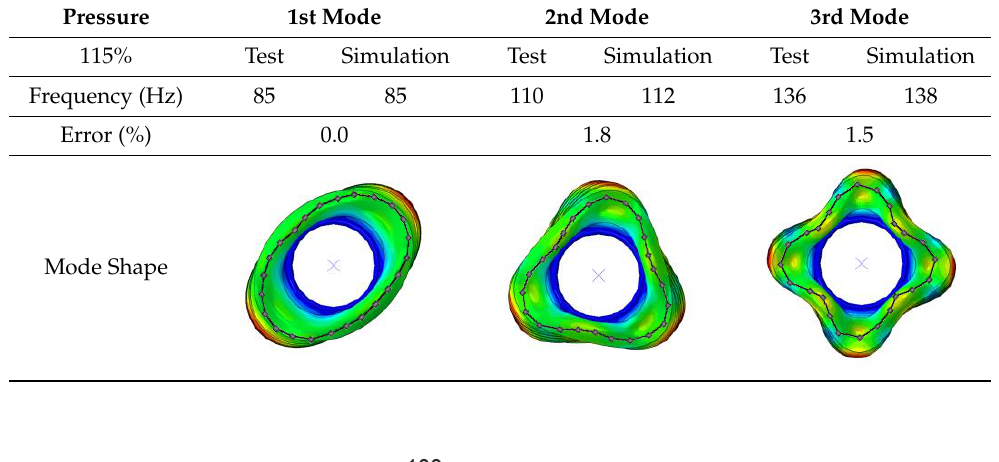
Table 8. Comparison of the modal frequencies and modal shape between the experiment and simulation (Pressure 115%).